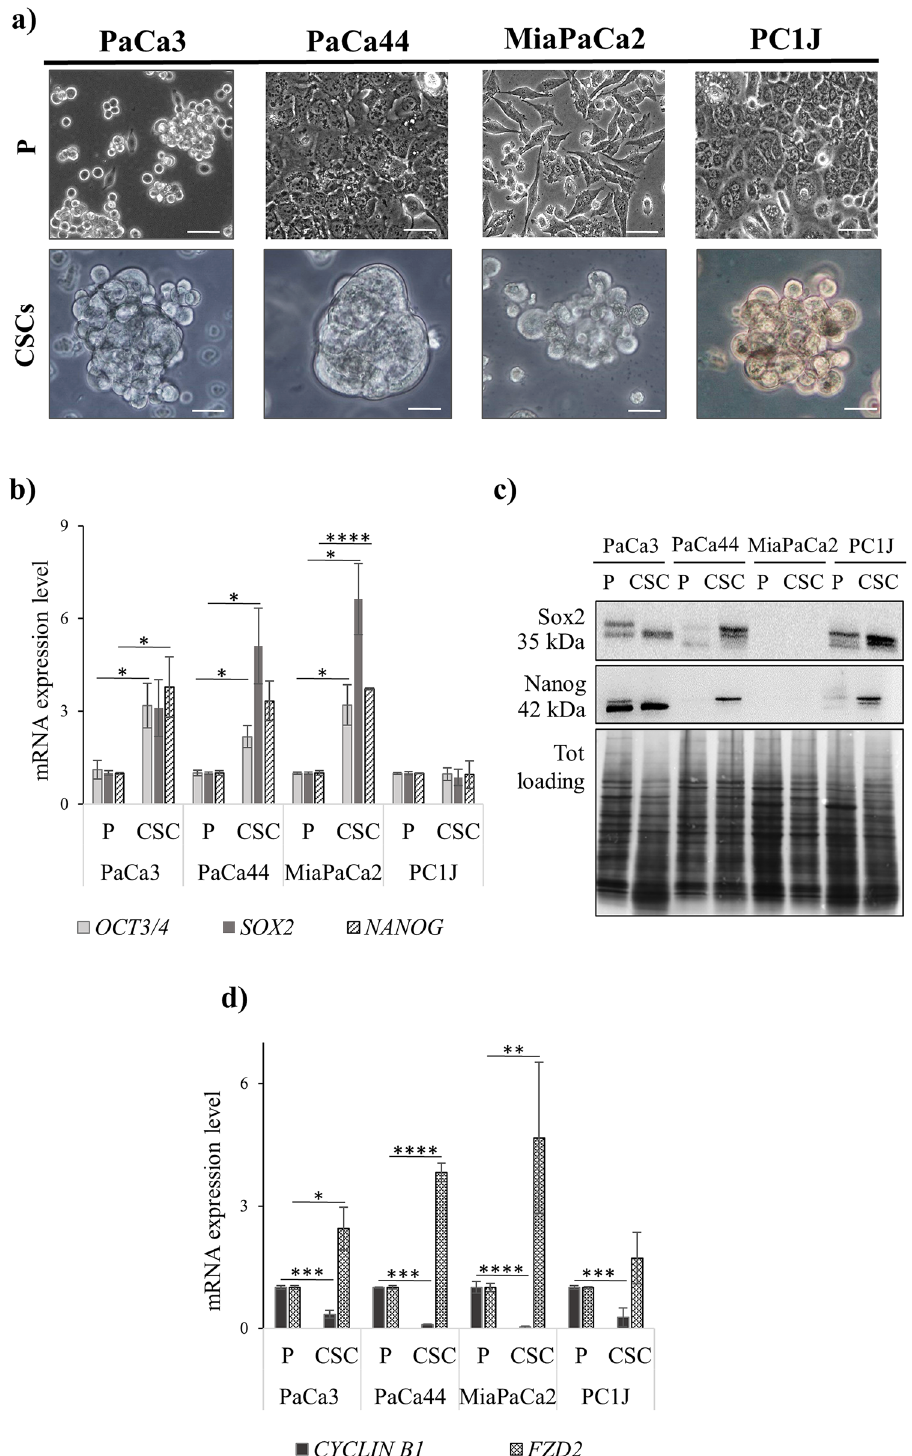
Figure 1. PCSCs grow as spheroids and have dysregulated levels of stemness and quiescence related markers. ( a ) Bright-field microscopy of P cells (upper lane) and PCSCs (bottom lane) obtained after 2 weeks of culture (× 20 magnification). Scale bar = 50 and 25 μm for P cells and PCSCs, respectively. ( b ) Histogram representation of q-PCR analysis of OCT3/4 , SOX2 , and NANOG gene expressions. ( c ) Immunoblotting assay of Sox2 and Nanog protein expressions. The blots were cropped to focus upon the specific proteins indicated. The full-length blots are presented in Supplementary Figure S1. ( d ) Histogram representation of q-PCR analysis of mRNA expression of cyclin B1 and FZD2 gene expressions. Results are reported as means ± standard error (SE) of three independent biological replicates; p < 0.05 (*), p < 0.01 (**), p < 0.001 (***), p < 0.0001